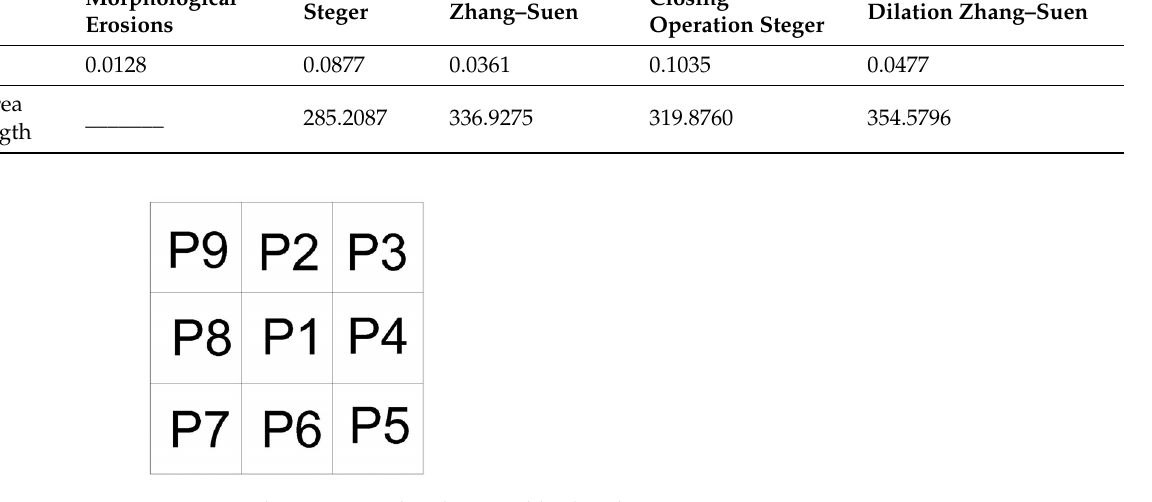
Figure 10. The target pixel and its neighborhood.